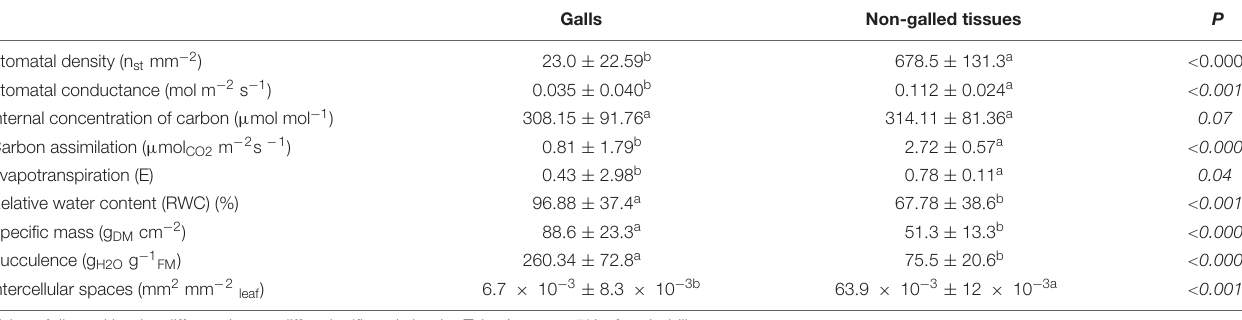
FIGURE 2 | Sugar and nitrogen contents in non-galled leaflets of Matayba guianensis and in galls induced by Bystracoccus mataybae (means ± standard deviation). TSS, total soluble sugars; WSP, water soluble polyssacharids. Values followed by the same letters, for each substance, do not differ significantly at P ≤ 0.05 level by the Tukey’s test. TABLE 1 | Means ± standard deviation ( n = 10) for physiological characteristics related to water content and physiological profile of non-galled tissues and galls induced by Bystracoccus mataybae on Matayba guianensis .